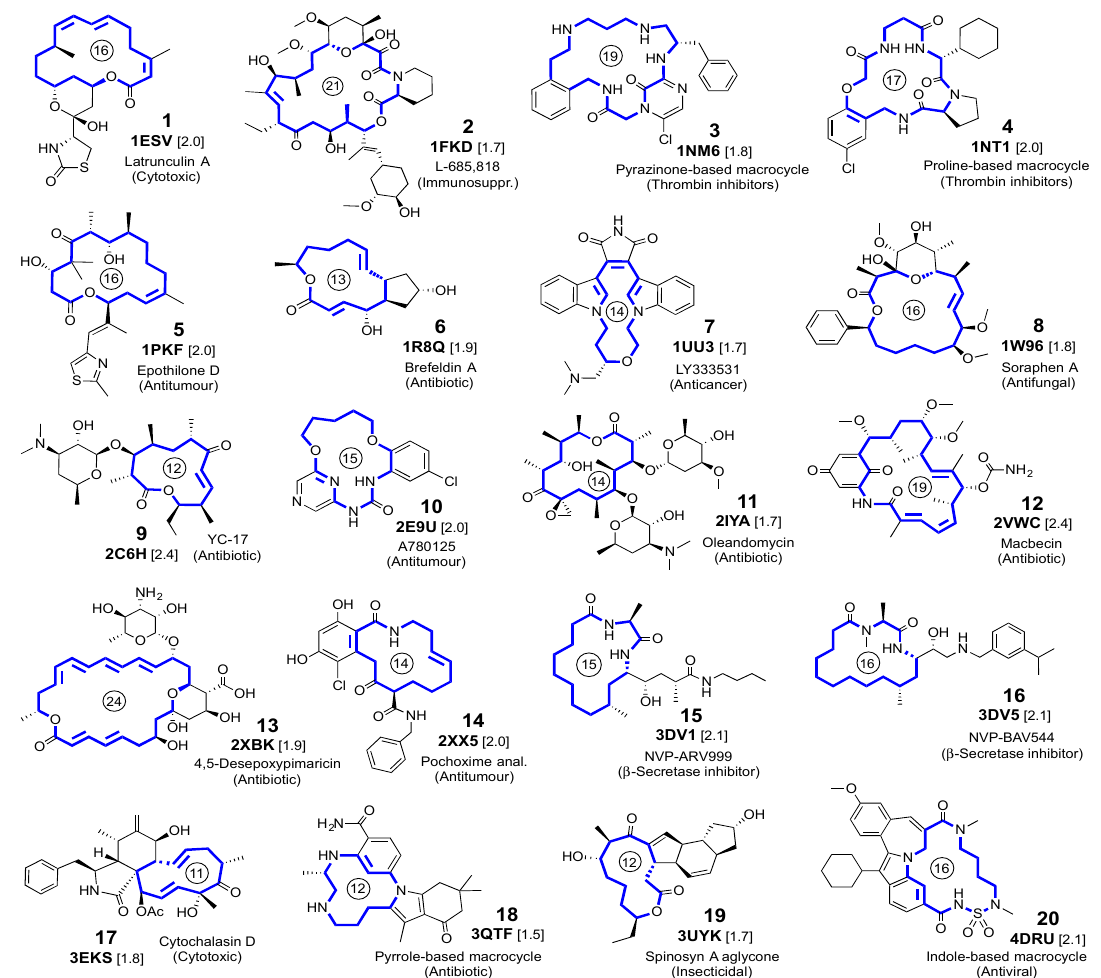
Figure 1. Selected ligands, with the PDB code and resolution (in Å, within brackets) of the crystalline complexes. For each macrocyclic ligand, the ring size is indicated by a number inside a circle.